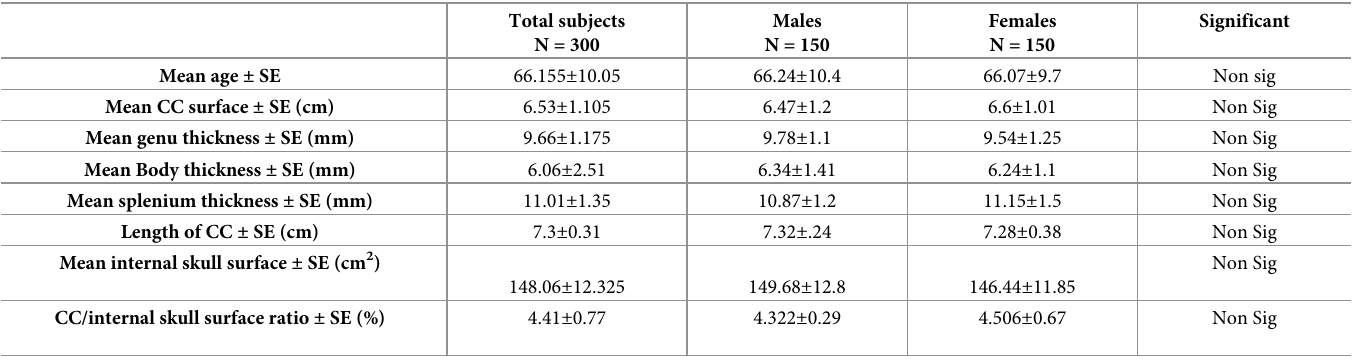
Table 1. Average CC mean values normal healthy individuals.